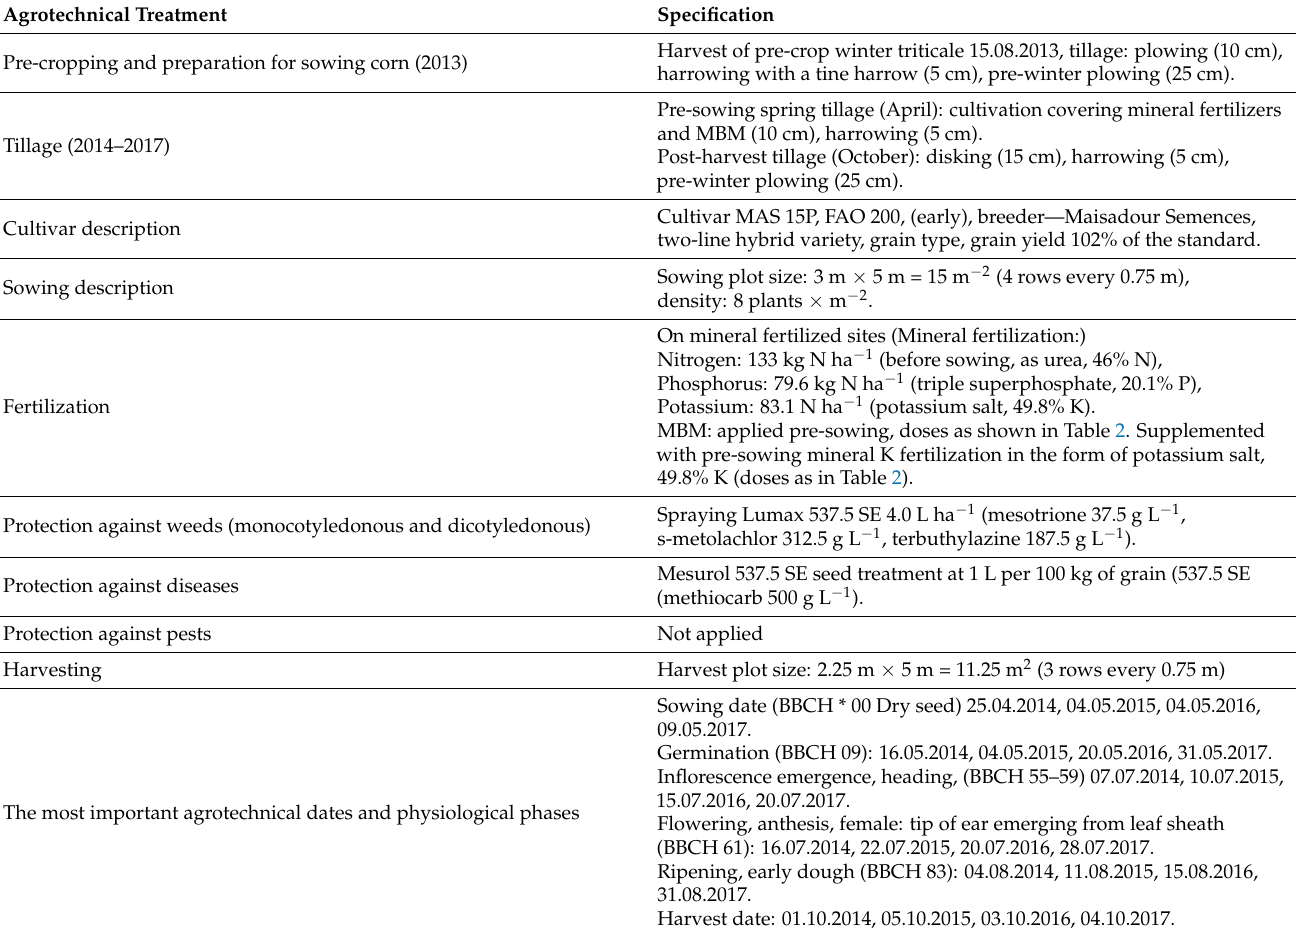
Table 1. Description of agrotechnology and the most important development phases of maize.